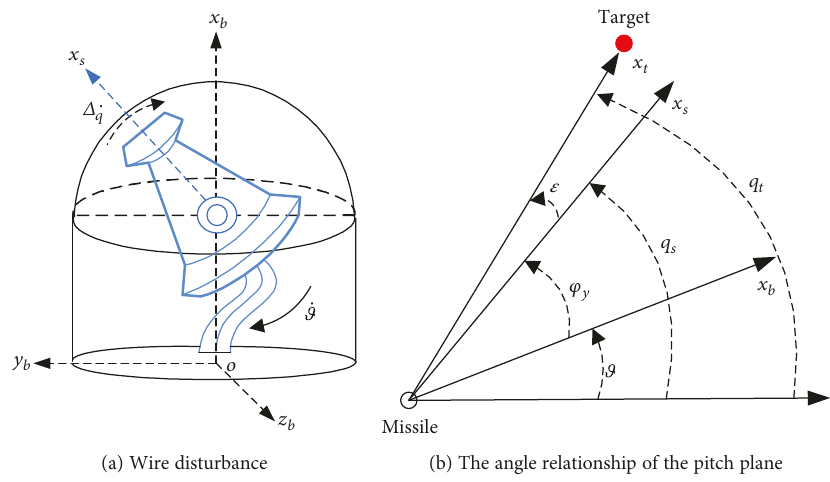
Figure 1: The structure of the platform seeker.